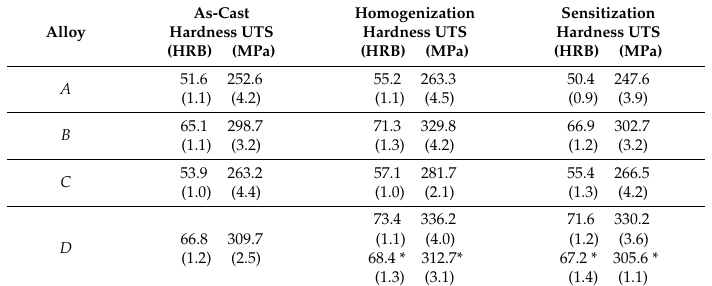
*: Homogenization and furnace cooling. Standard deviations are listed in